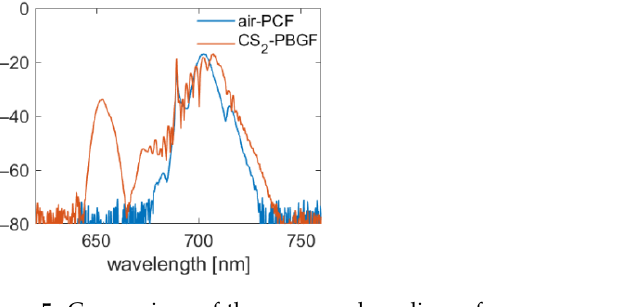
Figure 5. Comparison of the measured nonlinear frequency conversion spectra in the CS 2 -PBGF (blue) and air-hole based photonic crystal fibers (PCF) (orange) both for the same pump peak power (1.5 kW) and pump wavelength (700 nm).